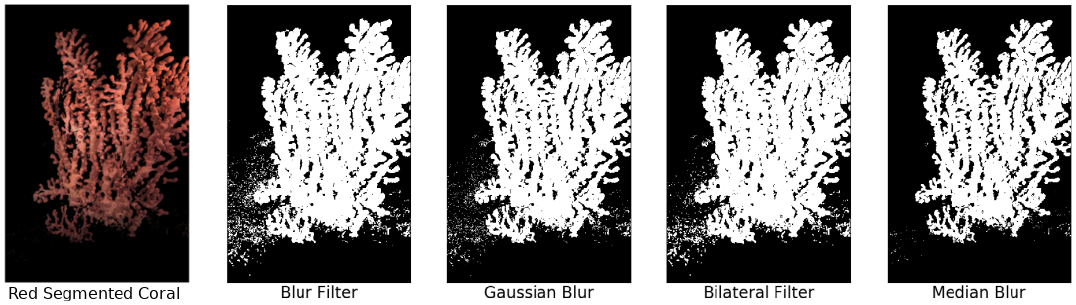
Figure 5. Red-segmented coral output and the image binarization according to the used filters.